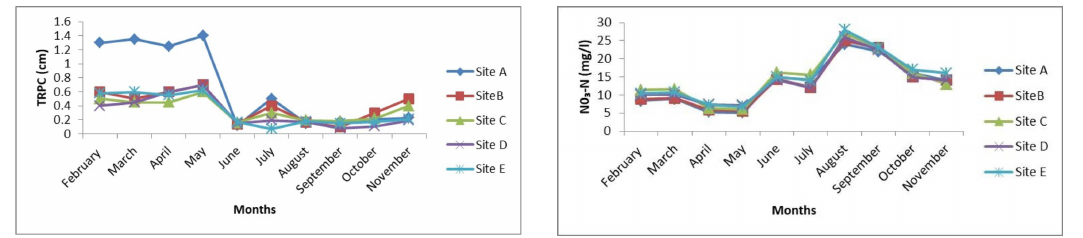
Figure 4. Monthly mean variations in transparency of Nasarawa Reservoir.